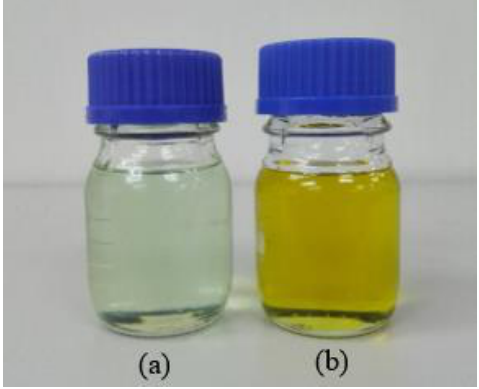
Figure 2. ( a ) Melaleuca Cajuputi oil and ( b ) refined palm oil.